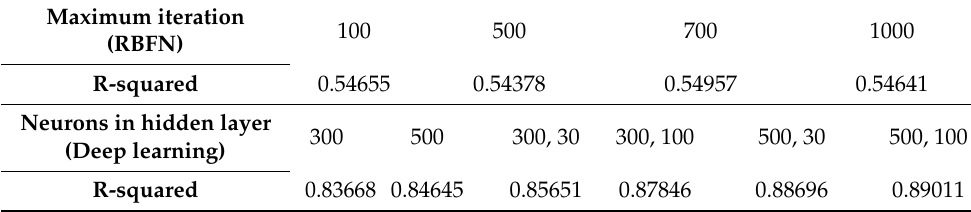
Table 1. Tuning of